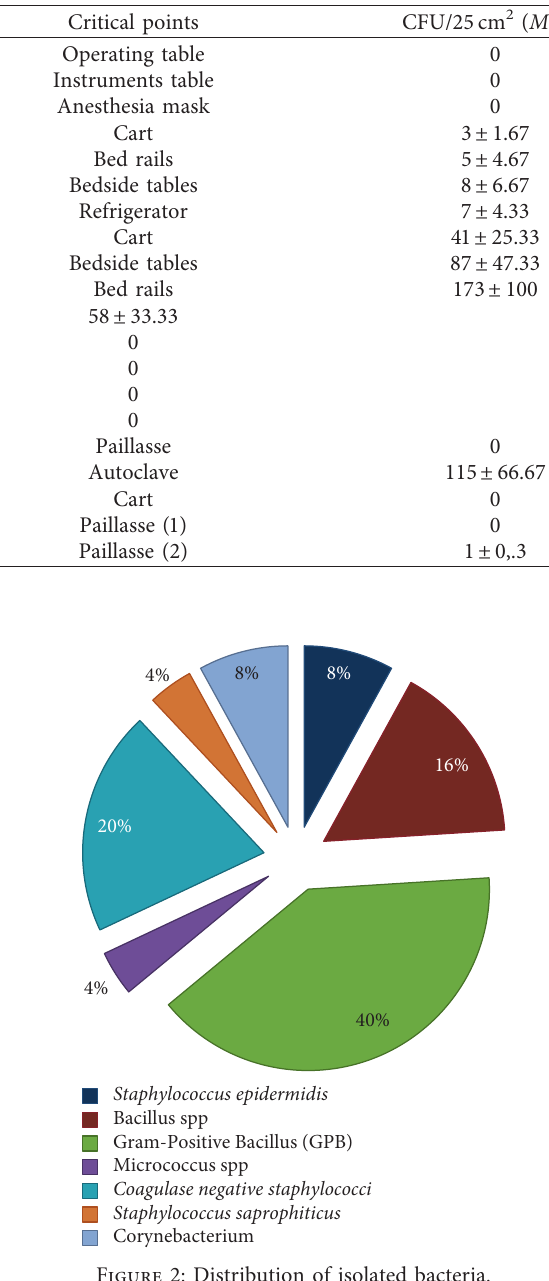
Table 1: CFU/25cm 2 found in the different critical points of the three services studied.